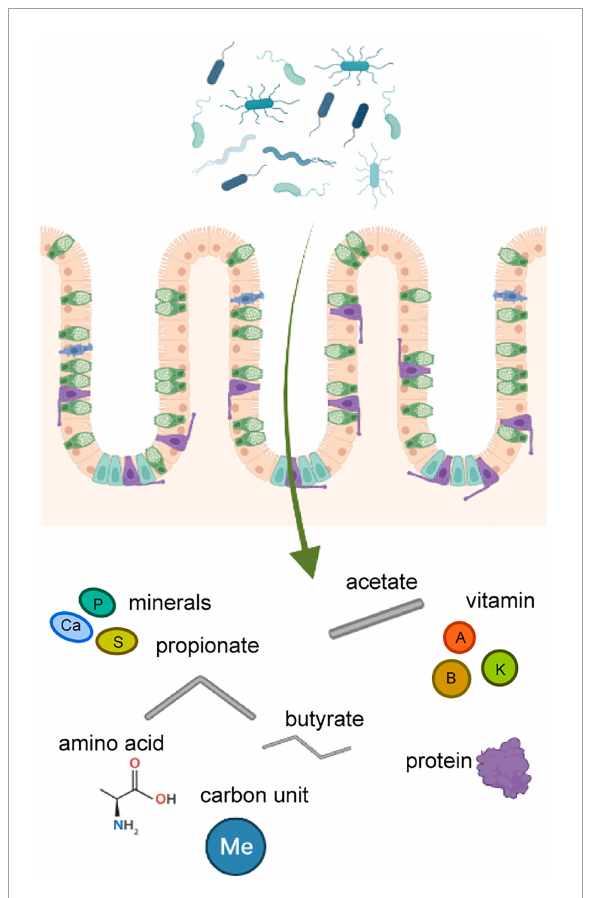
FIGURE1 The nutrient substance produced by gut microbiota. Products secreted by gut microbiota in the intestine affect the distal parts of body through the circulatory system. These substances include amino acids, proteins, vitamins, minerals, fatty acids, and so